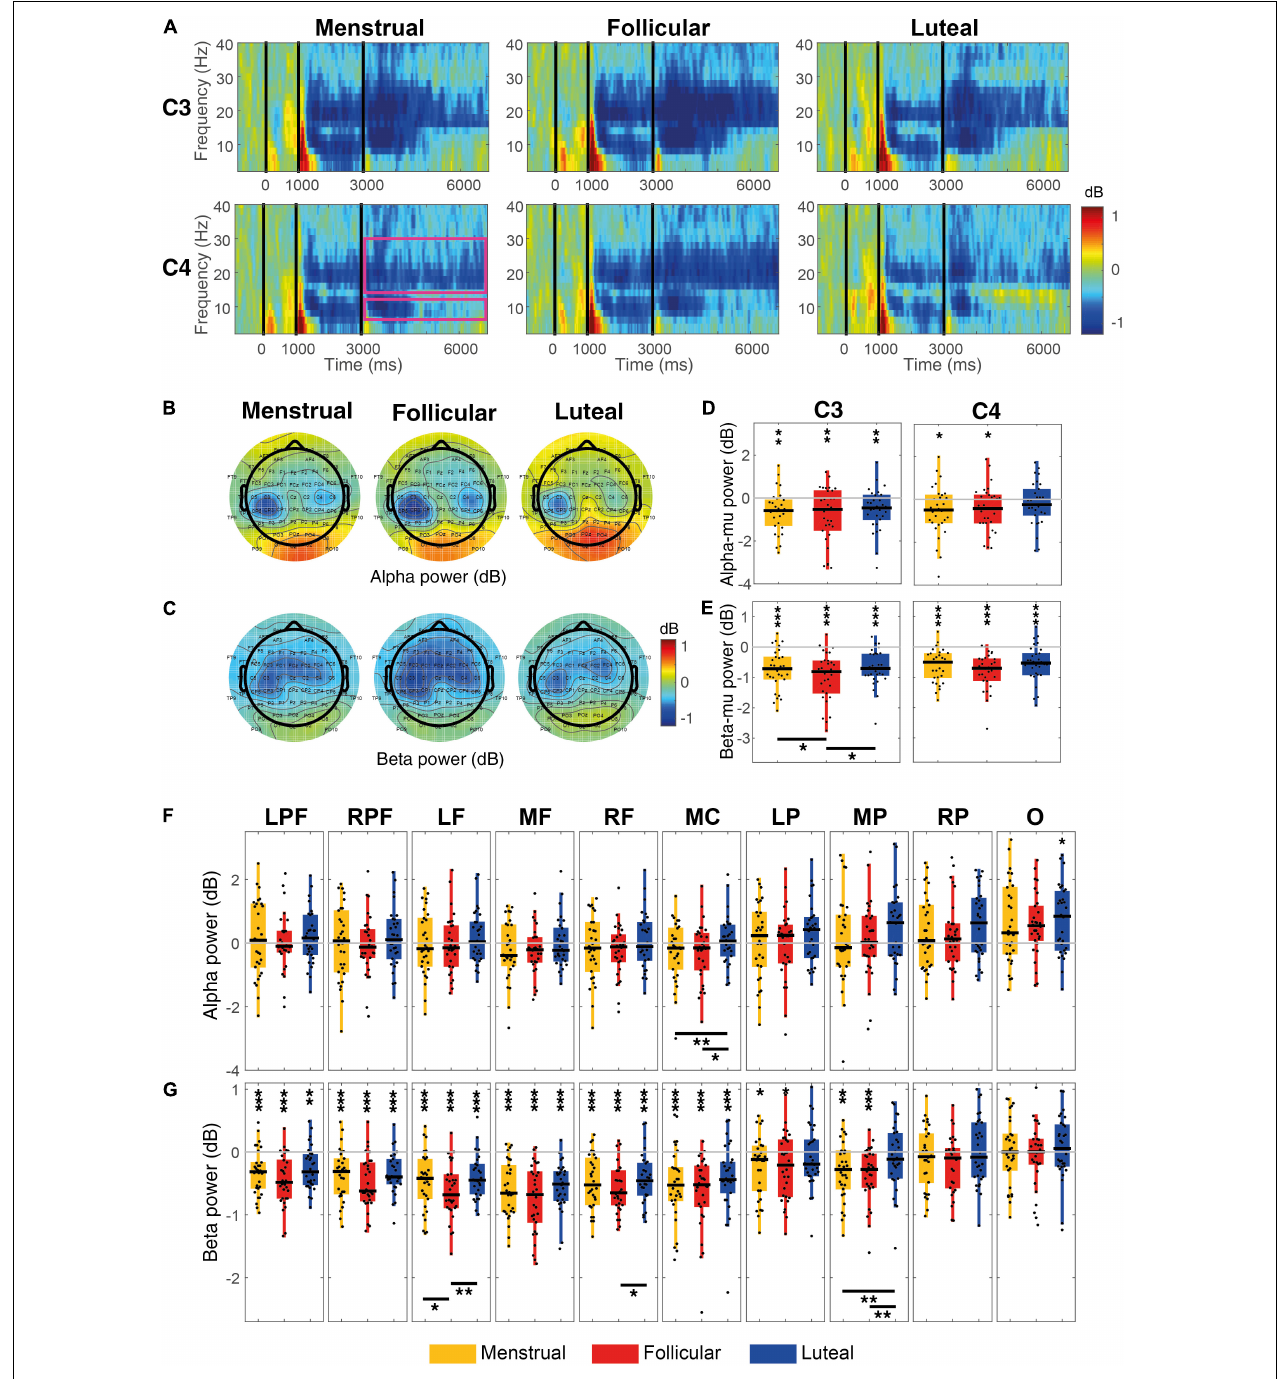
FIGURE 4 | Event-related power for each menstrual cycle phase during the MI condition. (A) Displays time-frequency plots of C3 and C4 electrodes by menstrual cycle phase. The pink rectangles in the first column and C4 row indicate the time-frequency interest limits: Event B time (3.15–7 s), alpha-band (8–13 Hz), and beta-band (15–30 Hz). (B) Shows topographies of the mean alpha power for each menstrual cycle phase and (C) shows topographies of the mean beta power for each menstrual cycle phase. Boxplots and scatter plots are presented in (D) with alpha-mu power, in (E) with beta-mu power per menstrual cycle phase and per cortical region, in (F) with alpha power for various regions of the cortex, and in (G) with beta power for various cortex regions. Asterisks located above boxplots indicate that the power was significantly different from zero in the menstrual cycle phase below. Asterisks located below boxplots indicate that the power was significantly different between the two menstrual cycle phases indicated by the horizontal line. * p < 0.05, ** p < 0.01, *** p < 0.001; C3, left central; C4,: right central; LPF, left prefrontal, RPF, right prefrontal, RF, right frontal, MF, medial frontal, LF, left frontal, MC, medial central, LP, parietal, MP, medial parietal, RP, right parietal and O,